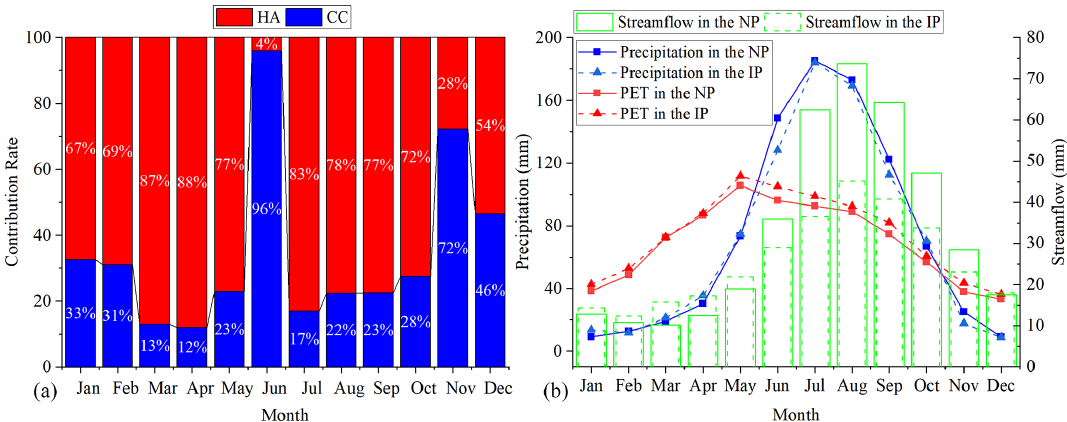
Figure 12. CR of CC and human activities to the changing monthly streamflow at Yunjinghong station (a) , monthly precipitation, potential evapotranspiration, and runoff depth during the natural period and the impacted period in the LR basin (b) . (Notation: HA: “human activities”, CC: “climate change”, PET: “potential evapotranspiration”, NP: “natural period”, and IP: “impacted period”.)